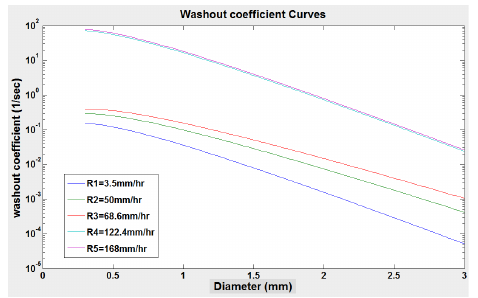
Fig. 6. Variation of washout coefficient with drop size